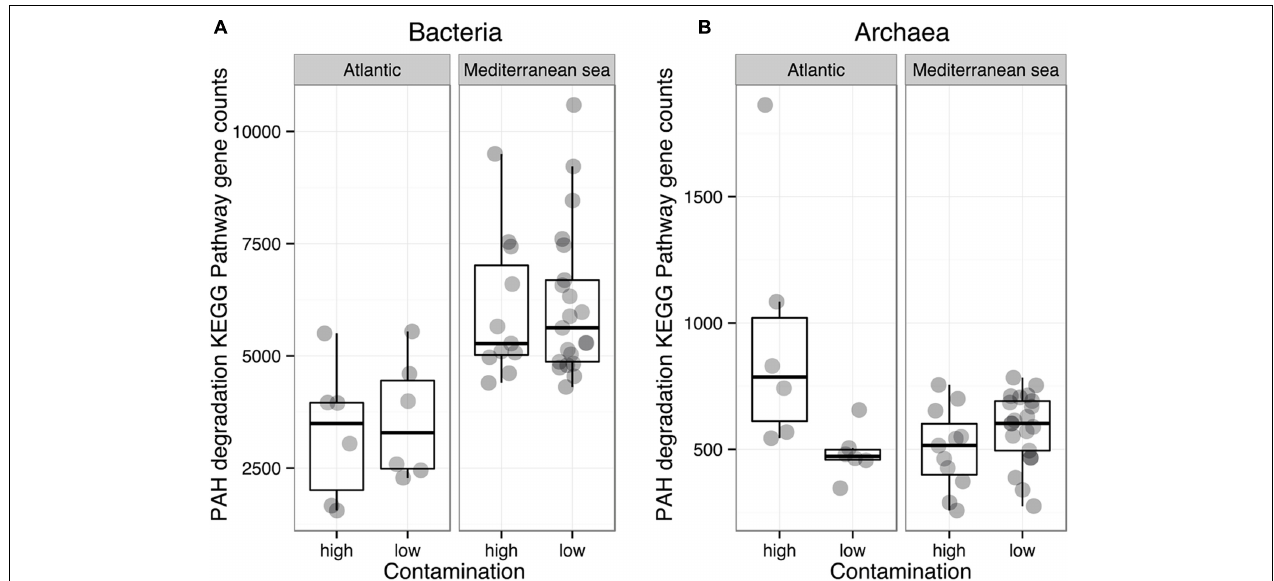
FIGURE 6 | Comparison of the mean abundances of bacterial (A) and archaeal (B) KEGG pathways related to the polyaromatic hydrocarbons (PAHs) degradation, within the Mediterranean and Atlantic geographic